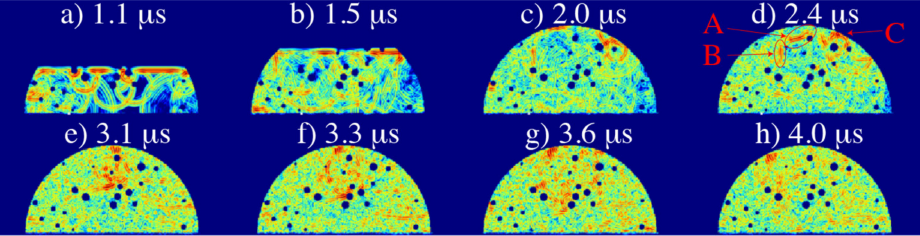
Figure 13. Simulated wave propagation in a 3 mm liquid water drop with 5% porosity. The transducer that sends and receives the ultrasonic signal is located on the flat surface at the bottom of the panels. The time for each snapshot after the start of the pulse is indicated. Darker red and yellow represent stronger waves (higher amplitudes), while blue colours correspond to low amplitudes. Although the dissipating effects caused by pores have a strong impact on wave front propagation, a small fraction of the wave front is reflected by the top of the drop surface after 2 µ s and arrives back to the transducer after 4 µ s. At 2.4 µ s, the reflected wave front A is about to merge with two intense wave fronts; on the left, B, and on the right side, C.